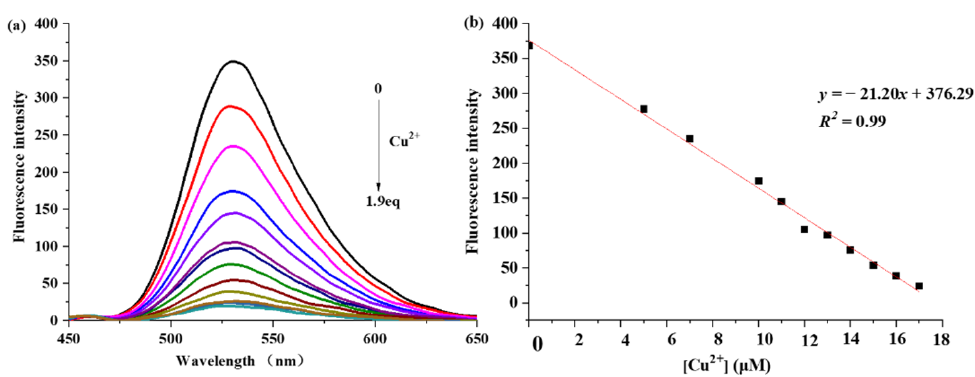
Figure 2. ( a ) Fluorescence spectrum of NPA on the addition of different amounts of Cu 2+ in a CH 3 CN solution; ( b ) the linear responses of NPA with Cu 2+ concentrations.